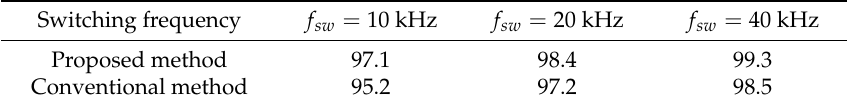
Table 2. Power efficiency with various switching frequencies